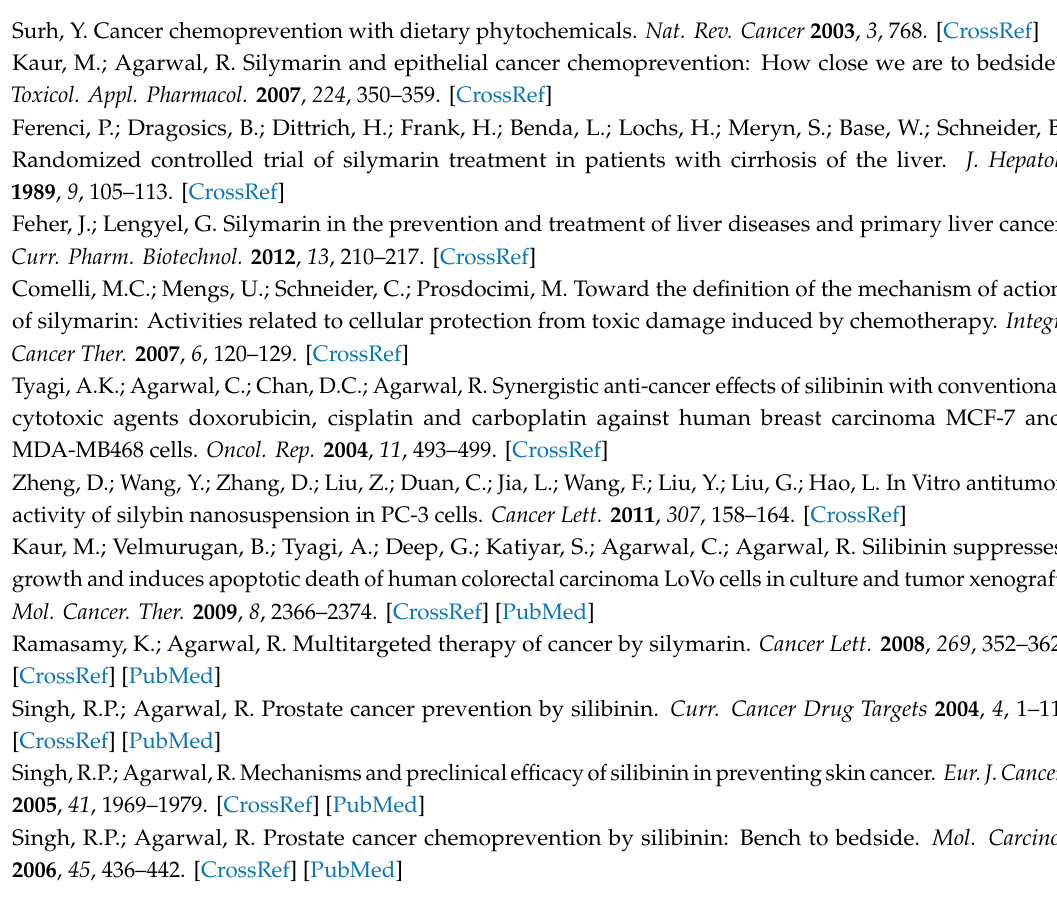
Supplementary Materials: The following are available online. Figure S1: MRM chromatogram corresponding to a urine blank sample (Panel A) and a urine zero sample (Panel B). In each panel: on the left MRM chromatogram corresponding to silibinin, on the right MRM chromatogram corresponding to the internal standard. Figure S2: MRM chromatogram corresponding to a pig muscle blank sample (Panel A) and a pig muscle zero sample (Panel B). In each panel: on the left MRM chromatogram corresponding to silibinin, on the right MRM chromatogram corresponding to the internal standard. Table S1: Total and free Silybin levels in plasma, urine, breast cancer, and adjacent una ff ected breast tissue in patients who received silybin for 28 days